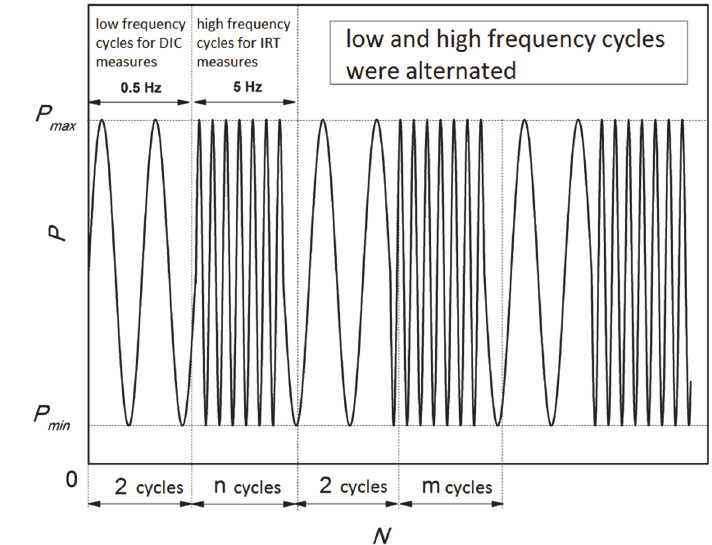
Figure 4: Profile of the applied load to allow IRT and DIC